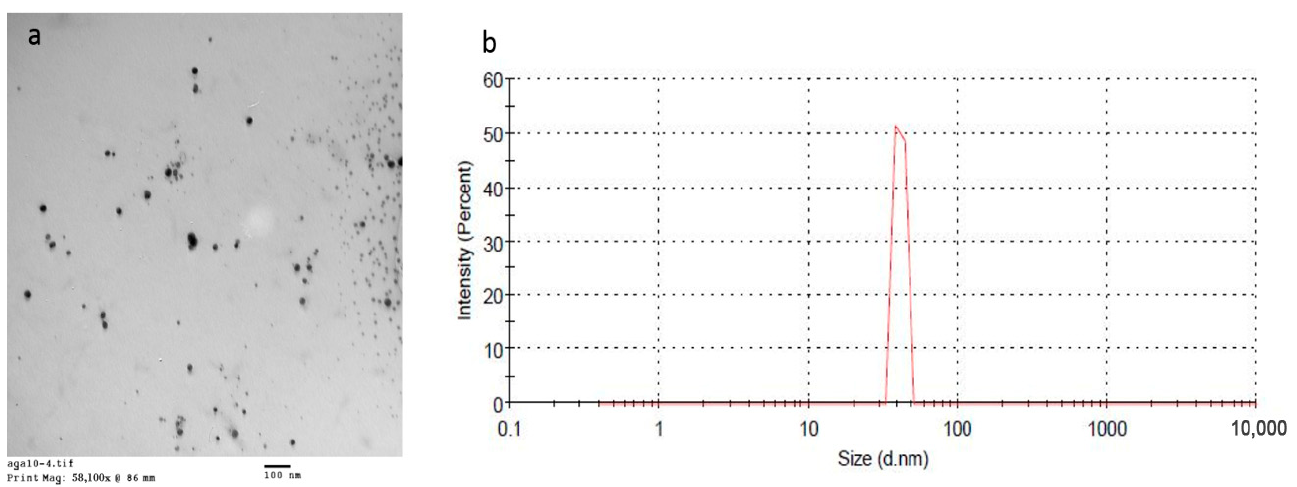
Table 2. Formulation parameters and characterization of BBE ‐ AgNPs. Values of particle size, PDI and EE% are presented as means of 3 samples ± SEM. AgNO 3 , silver nitrate; PDI, Poly dispersity index; EE% , Entrapment Efficiency.